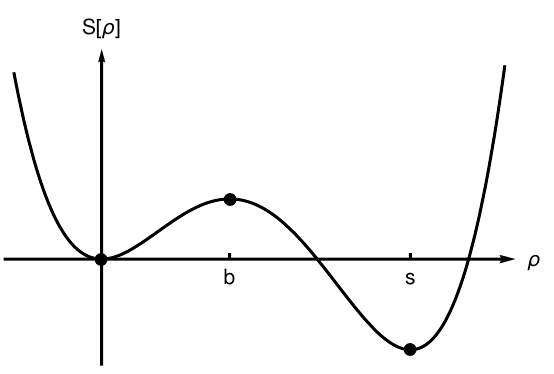
Figure 5 . The dependence of the Euclidean action S E [^ x ( (cid:28) ; (cid:26) )] on the parameter (cid:26) . The saddle points (marked with dots) are x F ( (cid:28) ), the bounce x B ( (cid:28) ) and the shot x S ( (cid:28) ) from the left to the right,